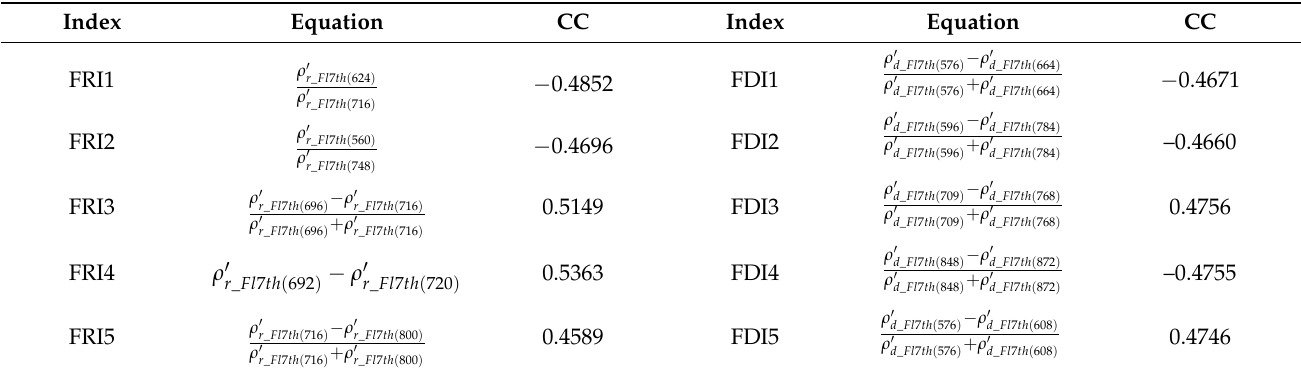
Table 4. The expressions of florescence difference index (FDI) and florescence ratio index (FRI) with high correlation with rice yield.